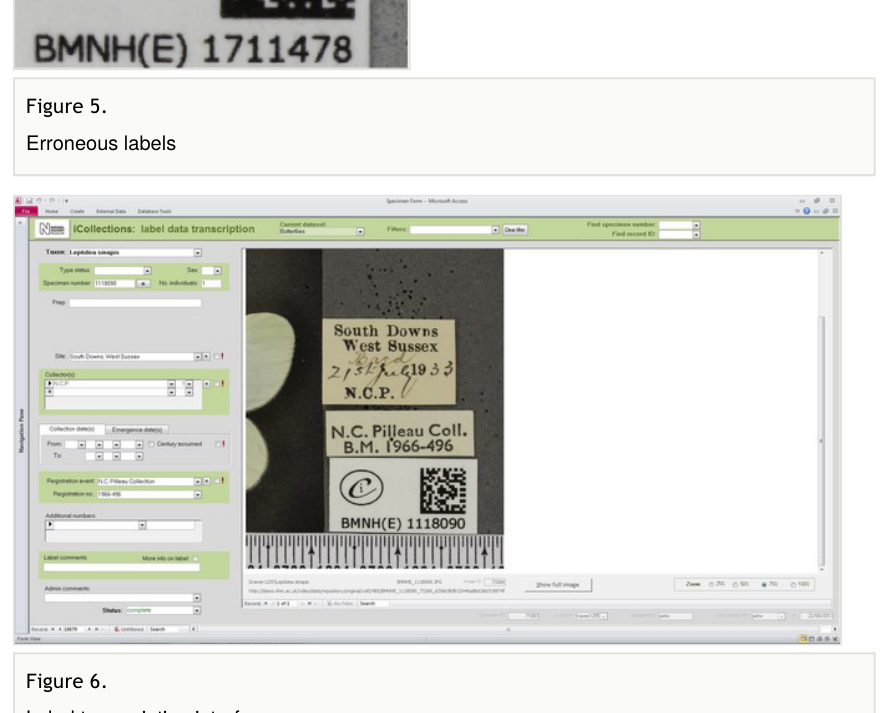
Figure 6. Label transcription